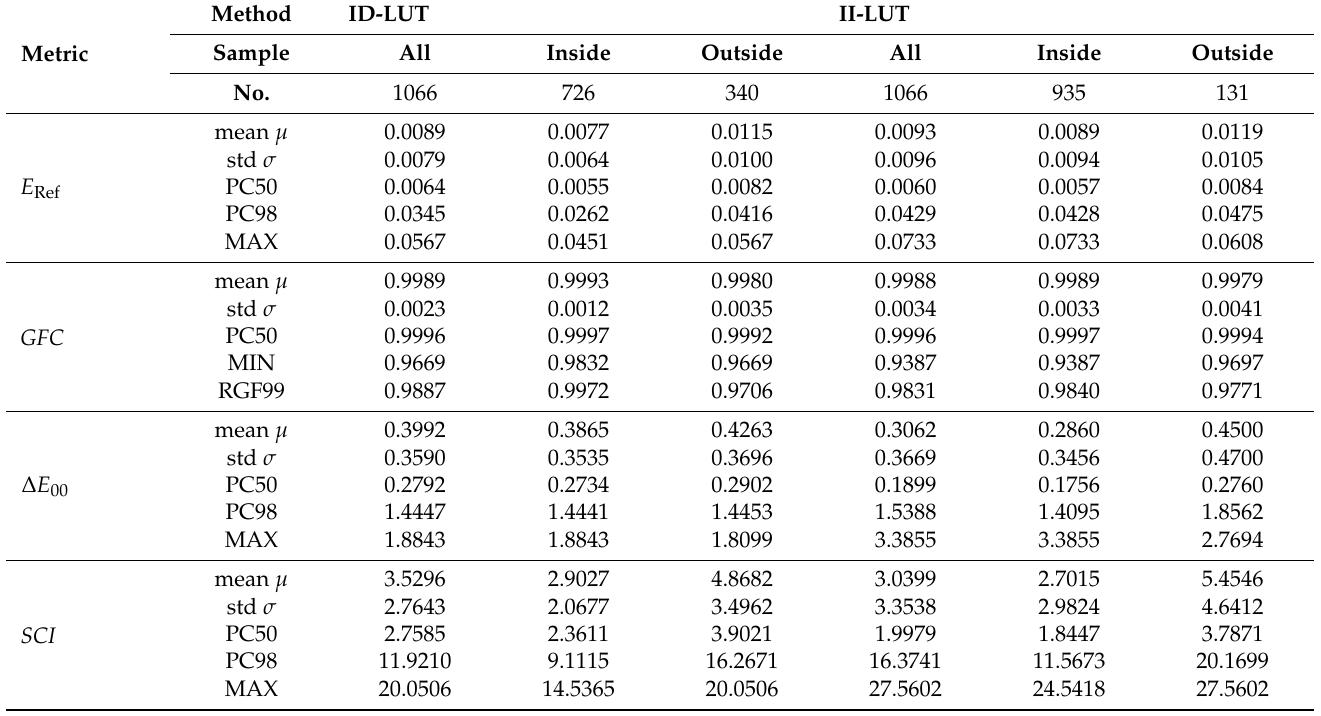
Table 3. Assessment metric statistics for the test samples using the ID-LUT and II-LUT methods, where the camera is the RGBF